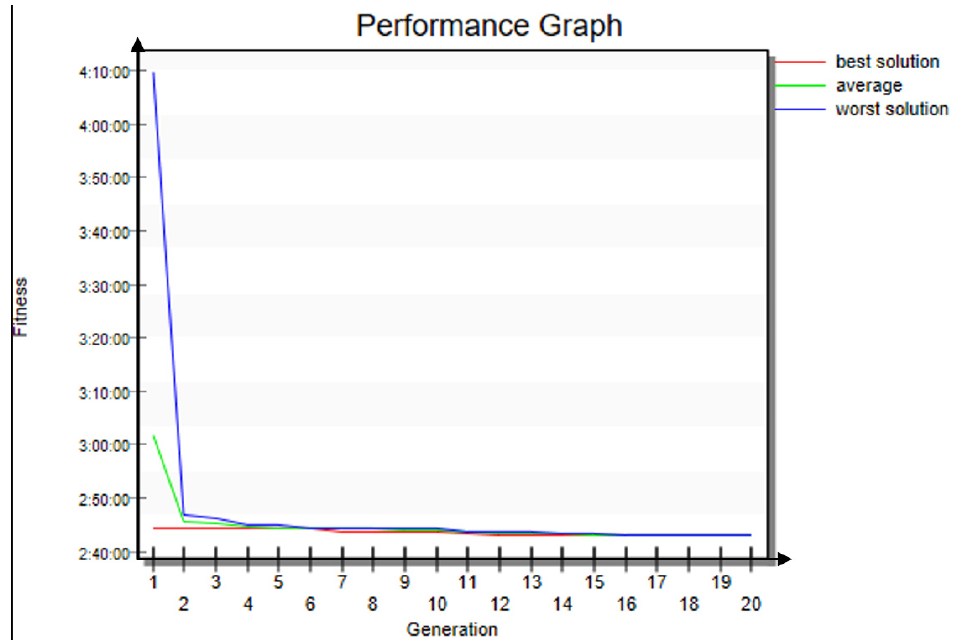
Figure 10. Graph showing the development of fitness values for the best, average, and worst solution in each generation.